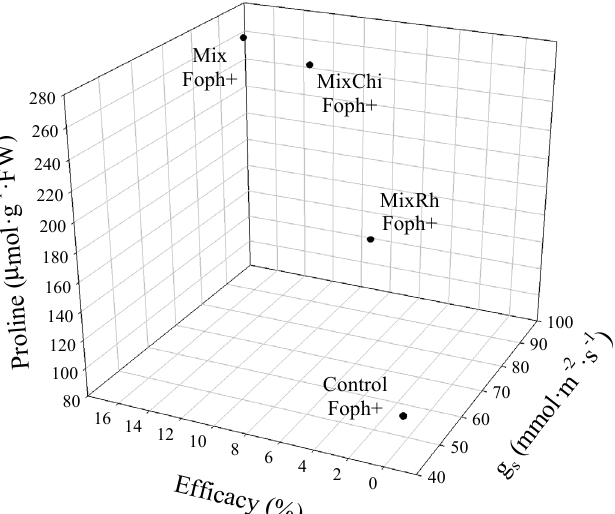
Figure 8. Three-dimensional analysis among stomatal conductance (g s ), percentage of efficacy, and proline content to identify the best treatments of mixtures of biological control agents and organic additives (Mix ( T. virens + B. velezensis ), MixRh ( T. virens + B. velezensis + burnt rice husk), and MixChi ( T. virens + B. velezensis + chitosan) on the control and physiological behavior of cape gooseberry seedlings inoculated with F. oxysporum f. sp. physali (Foph + ).